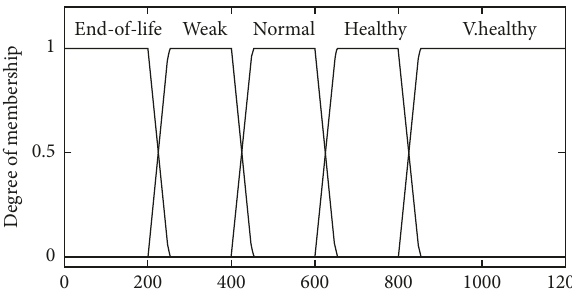
Figure 4: Output variable membership function-DP